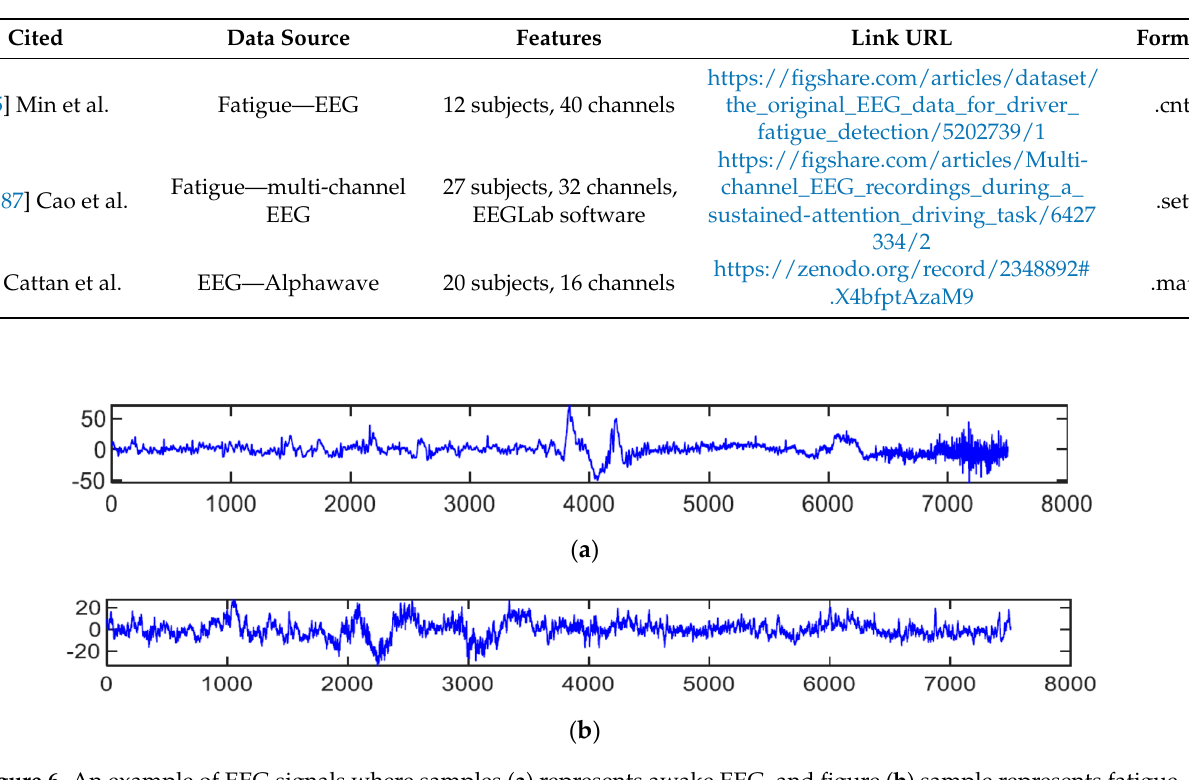
Figure 6. An example of EEG signals where samples ( a ) represents awake EEG, and figure ( b ) sample represents fatigue EEG signals. Table 5. Online multi-sensors based datasets are available to train and test the network by using EEG sensors data. Cited